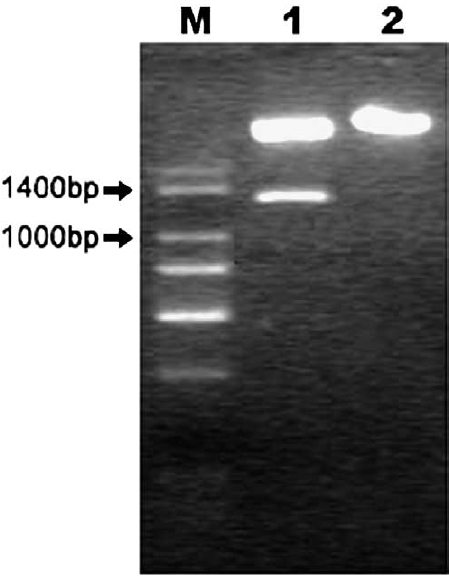
(46.9 kD) + HA (4.1 kD).